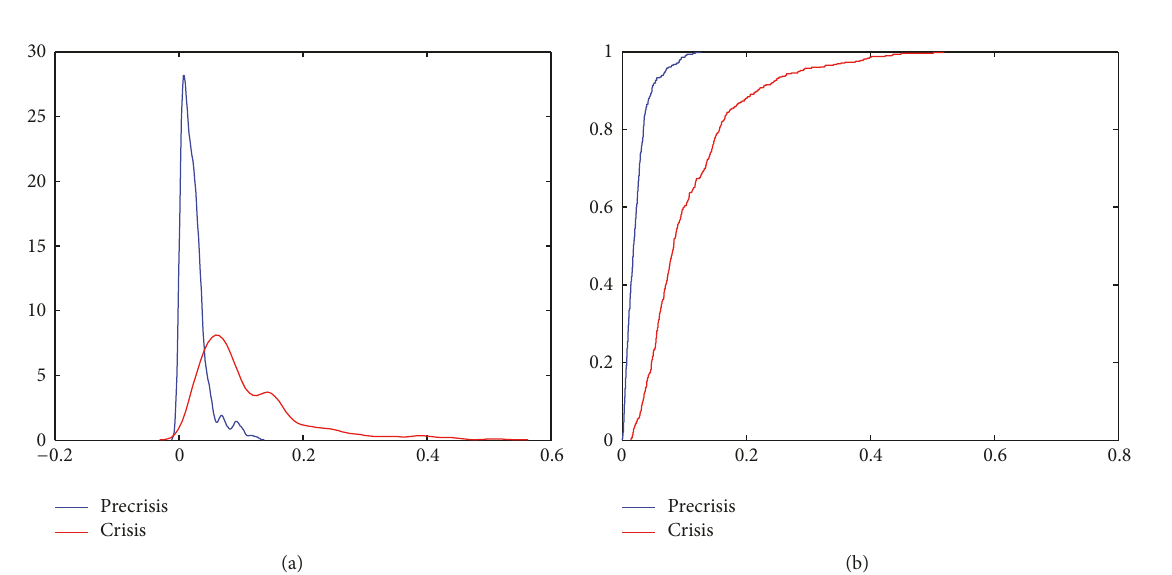
Figure 2: The probability density function curves (a) and the cumulative probability function curves (b) for the MI values of the entire precrisis and crisis periods.